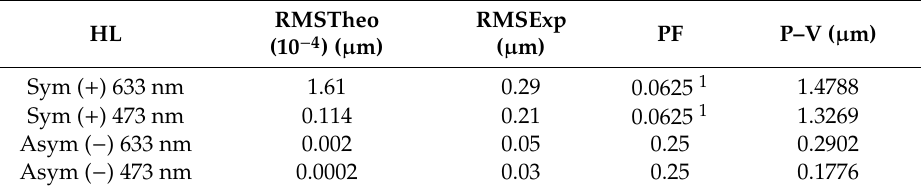
Table 3. Optical quality metrics based on